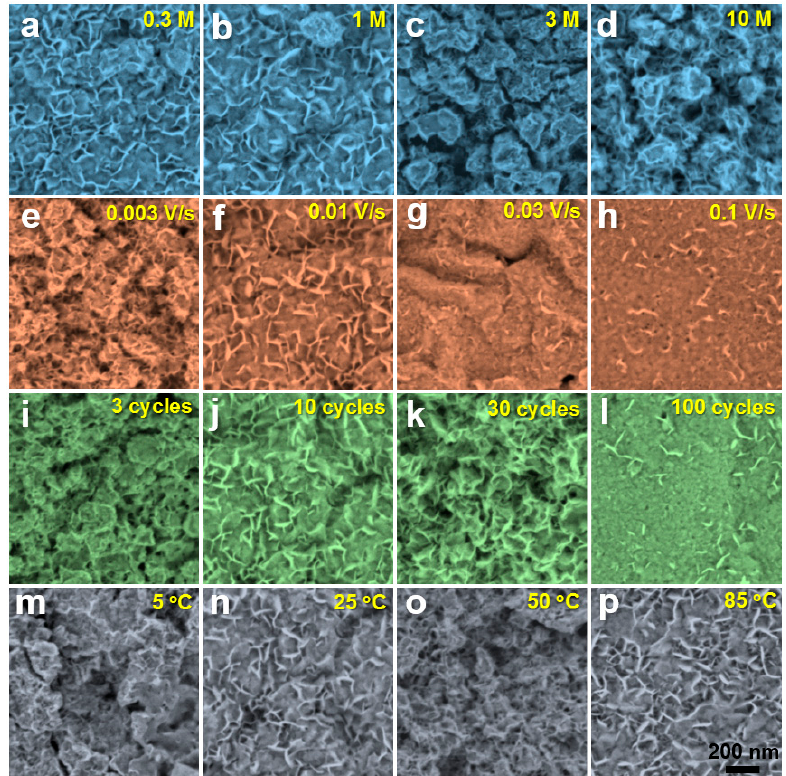
Figure 3. Back-scattered electron (BSE) images of GRs treated by CV under different technological conditions: ( a – d ) different KOH solution concentrations, with a scan rate of 0.01 Vs − 1 at 25 °C for 10 cycles; ( e – h ) different sweep rates, in 1 M KOH solution at 25 °C for 10 cycles; ( i – l ) different cycle numbers, with a scan rate of 0.01 Vs − 1 in 1 M KOH solution at 25 °C; ( m – p ) different reaction temperatures, with a scan rate of 0.01 Vs − 1 in 1 M KOH solution for 10 cycles.